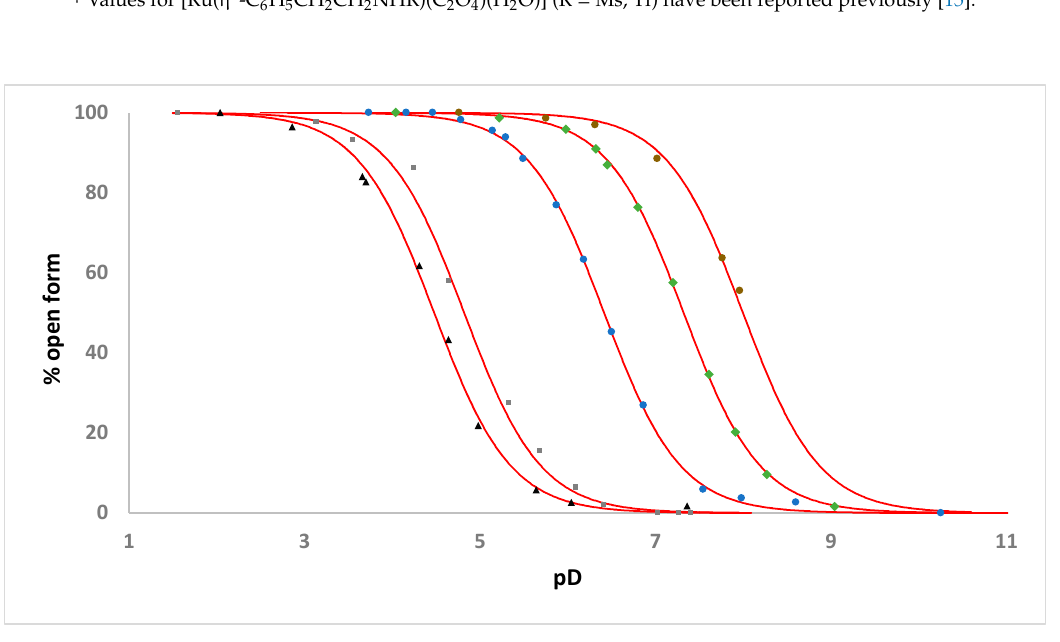
Figure 7. pH dependence of intramolecular sulfonamide ligation for 1 (green diamonds), 2 (blue circles), 3 (black triangles), 4 (grey squares) and 5 (brown circles) (2.46 mM complex, D 2 O, 295 K, 0.1 M NaCl) (Appendix A). pD values are determined using pD = pH meter reading + 0.4 [20]. The solid red lines represent the fit of the Henderson-Hasselbalch equation to each set of experimental data.